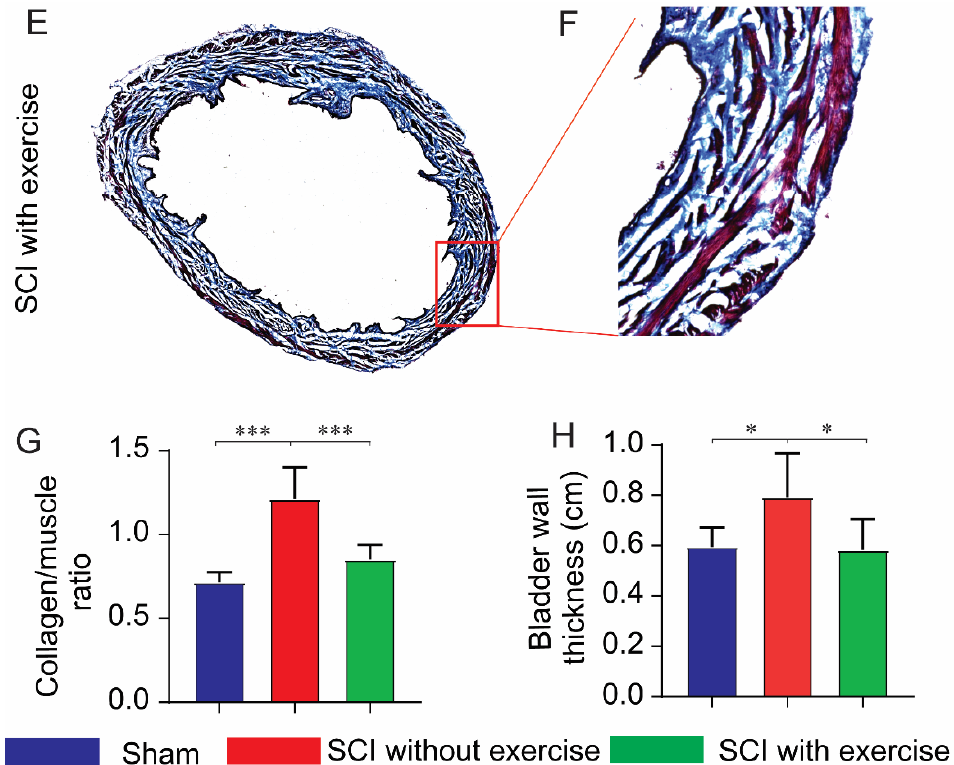
Figure 5. Locomotor exercise ameliorates bladder morphology. ( A , C , E ) Cross-sections of bladder stained with Masson’s trichrome in low magnification. ( B , D , F ) Areas within red dashed rectangles in high magnification. Red, muscle fibers; blue, collagen. ( G ) SCI increased the collagen/muscle ratio while exercise reduced this ratio. ( H ) SCI induced hypertrophy of bladder wall, but exercise reversed hypertrophy. *: p < 0.05; ***: p < 0.001. Scale bar 500 µ